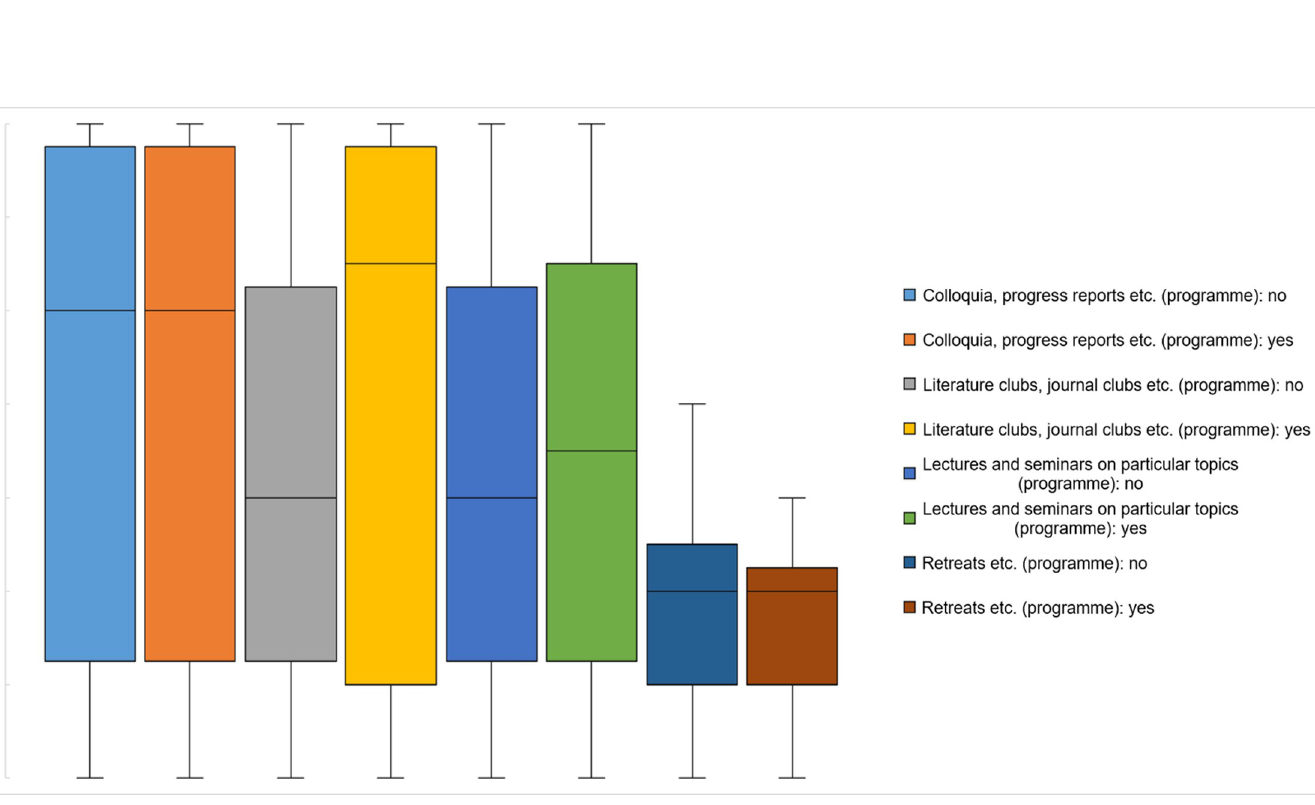
PLOS ONE | https://doi.org/10.1371/journal.pone.0233415 July 30,